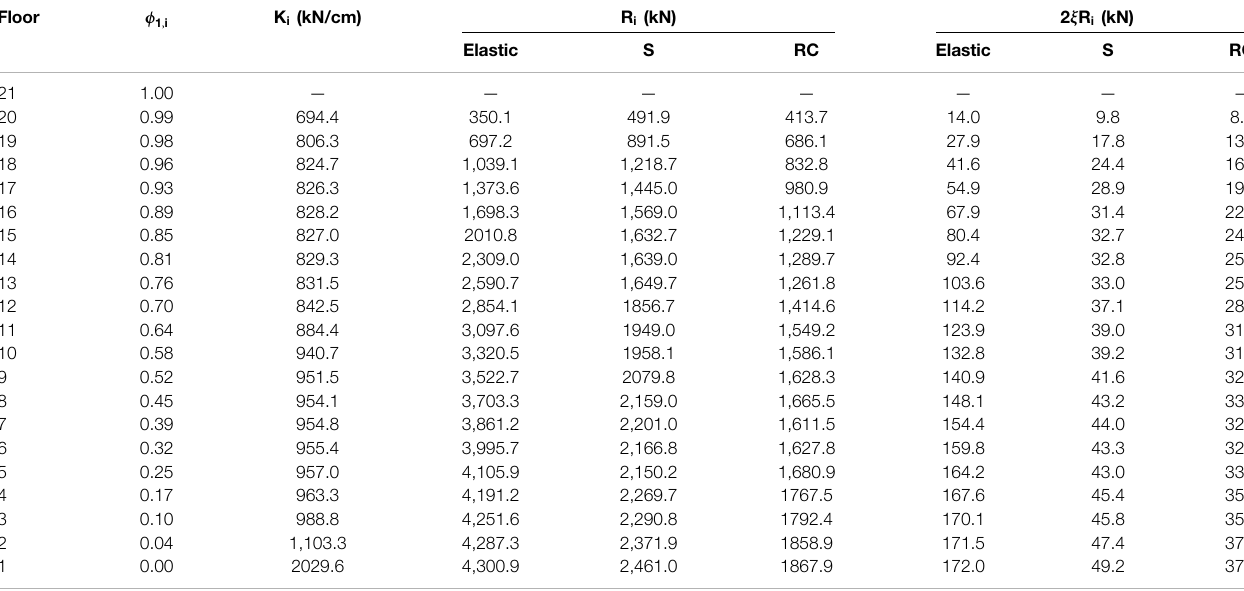
TABLE 4 | Interstory capped damping force 2 ξ R i of CP(O) estimated from seismic RHA. Floor ϕ 1 , i